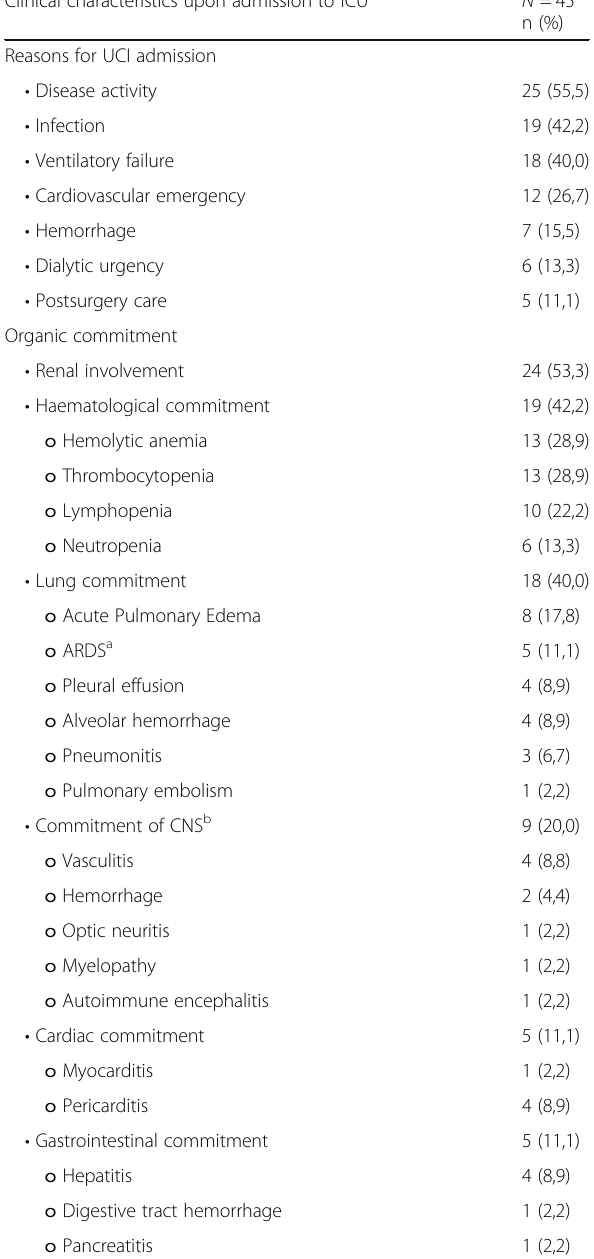
Table 3 Clinical characteristics upon admission to ICU in